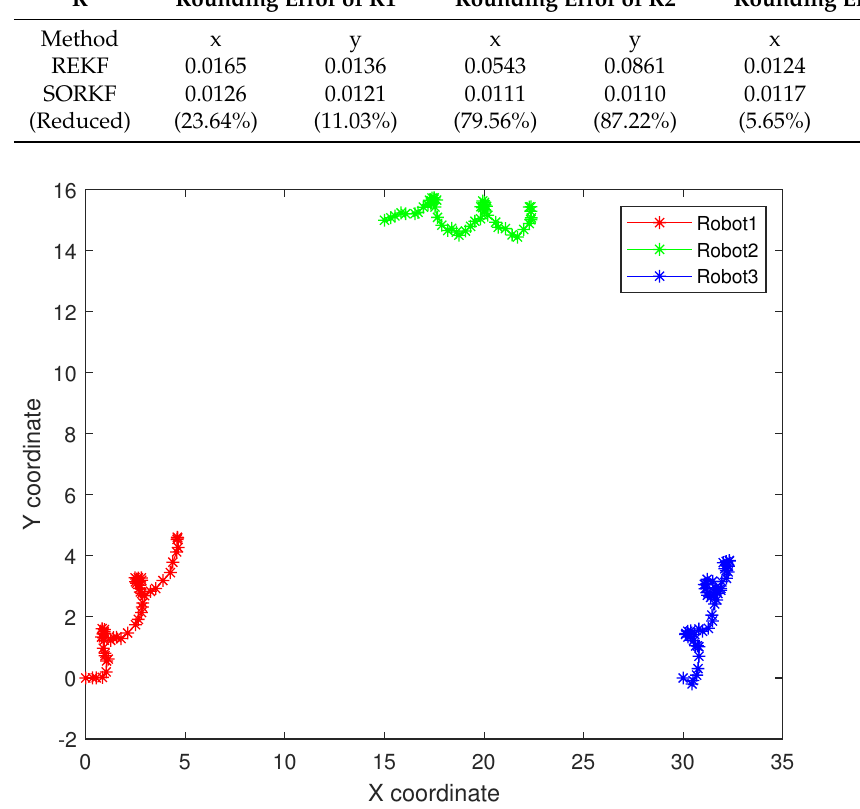
Figure 11. The real trajectory of the multi-robot swarm in random topology